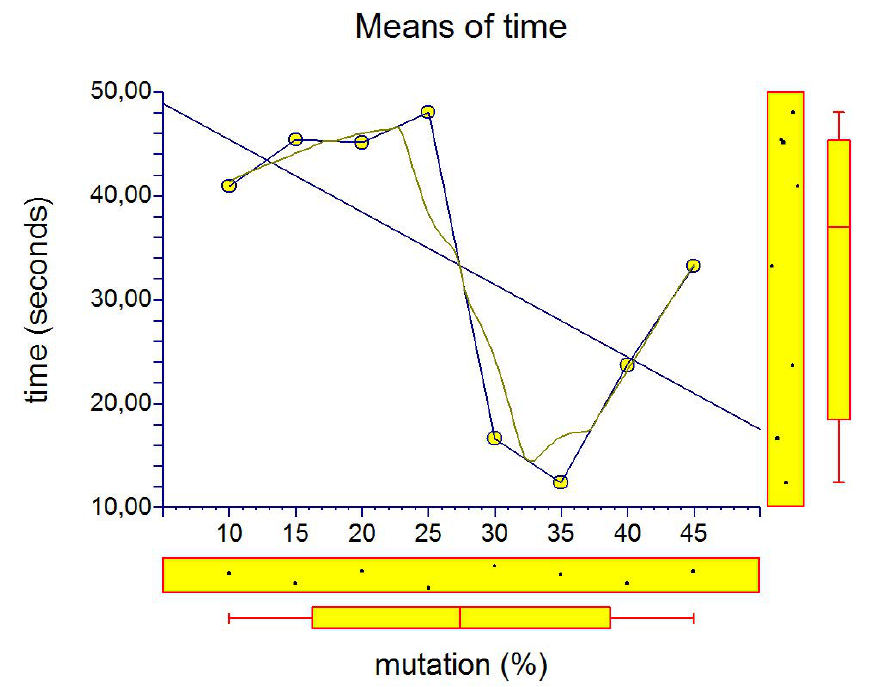
Figure 9. Exp. 1—Computing time means.